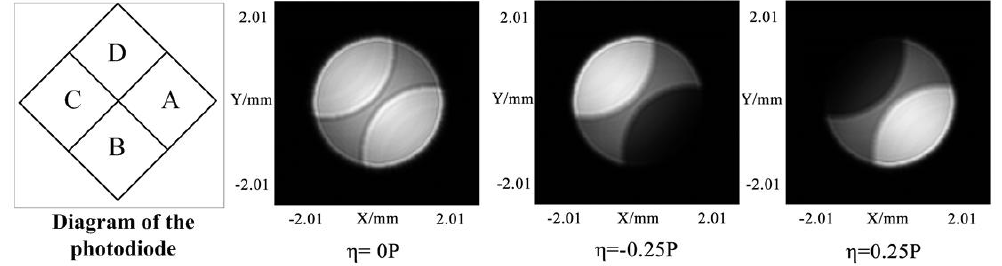
Figure 4. Light intensity distribution of the reflected beam with different TP deviation.  is the TP deviation. P is the track